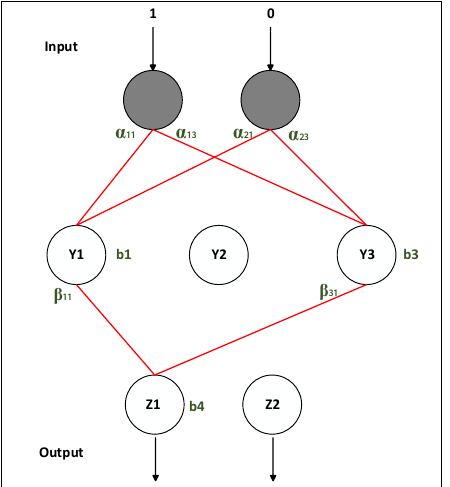
Figure 5. Feeding the first coordinate vector (1,0) to get the first component of the etalon (𝑊 𝑋 ) 𝑍 . Components that were frizzed 1 during step 1 of the algorithm 1 aren’t shown.